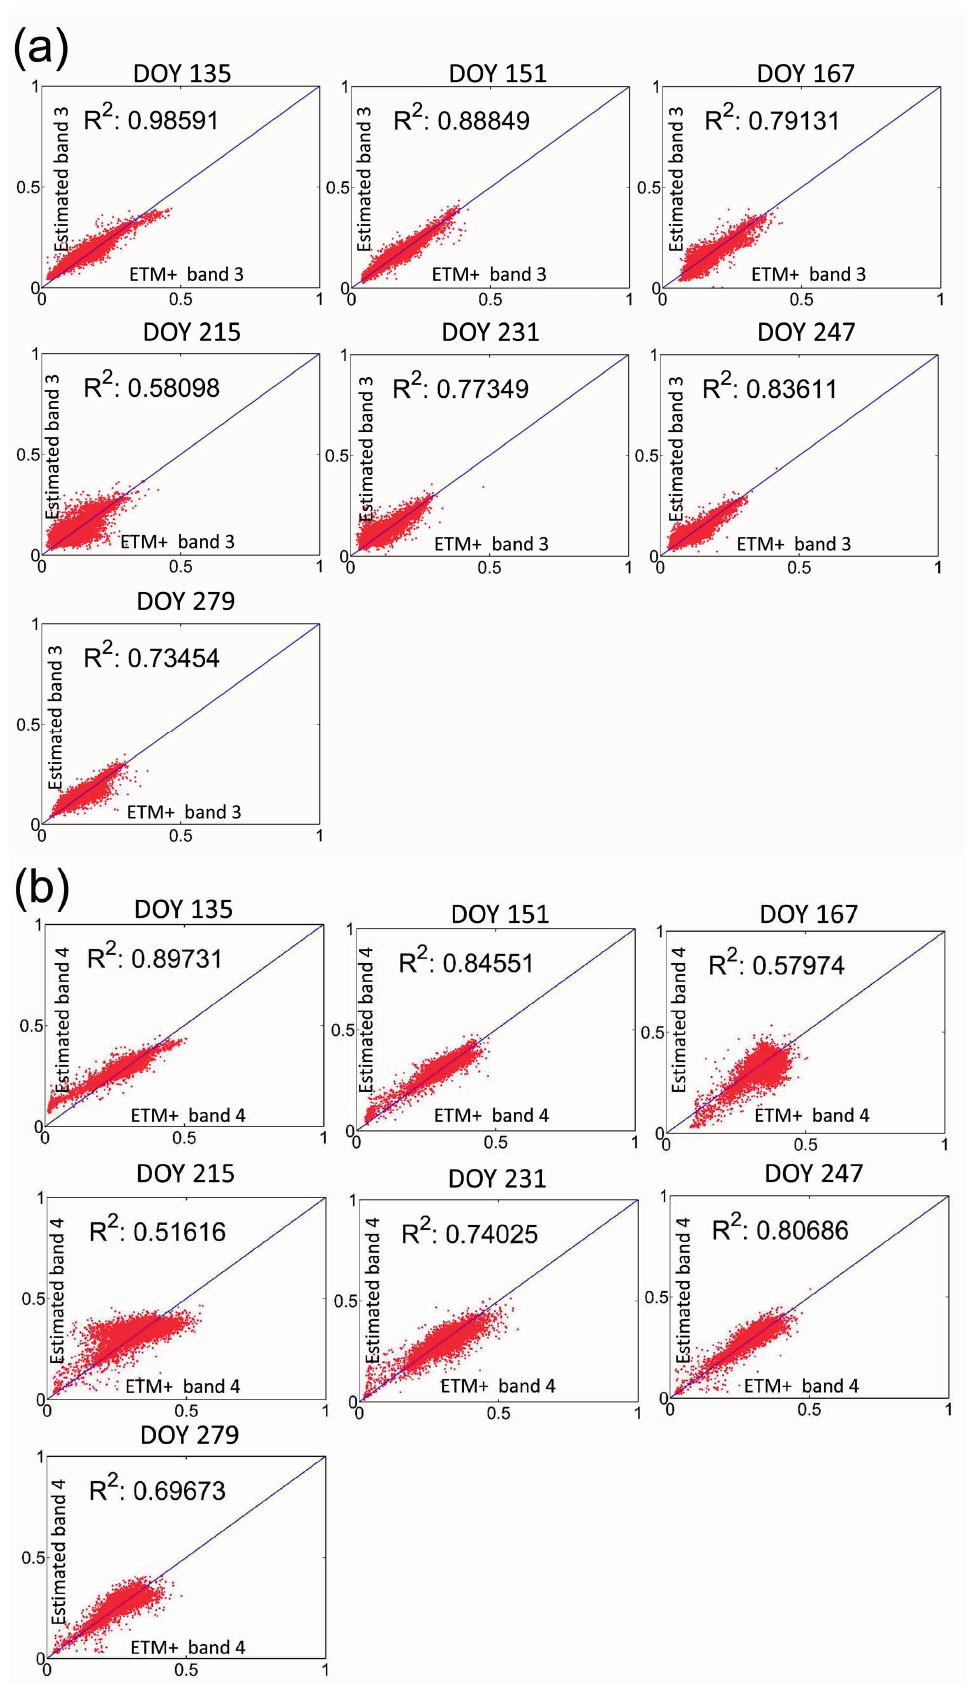
Figure 8. Scatterplots of the blended and the ETM+ data for the 134_32/33 sub-area. ( a ) scatterplots of the red band; ( b ) scatterplots of the near infrared